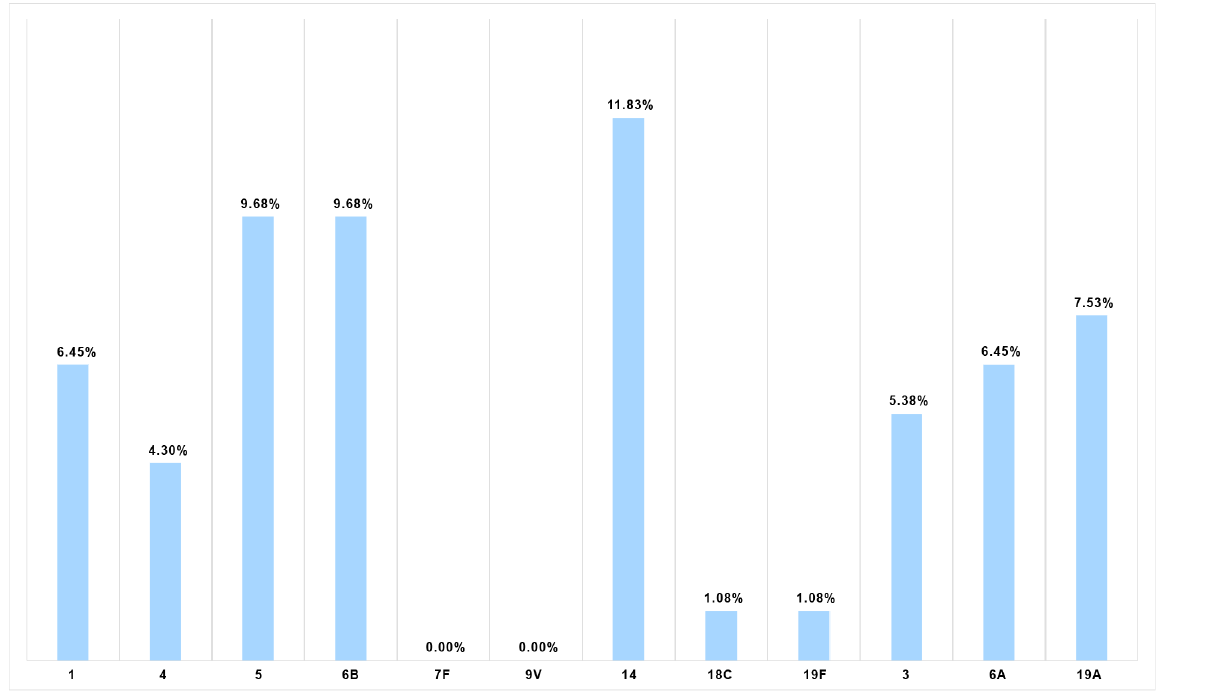
Fig 2. Proportion of IPD serotypes among Filipino children aged < 5 years covered by PCV13 (N = 93).